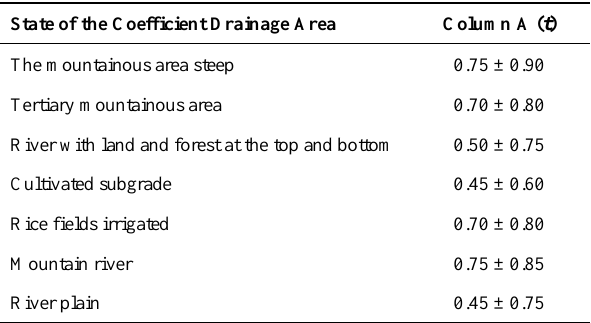
Table 1. Runoff coefficient